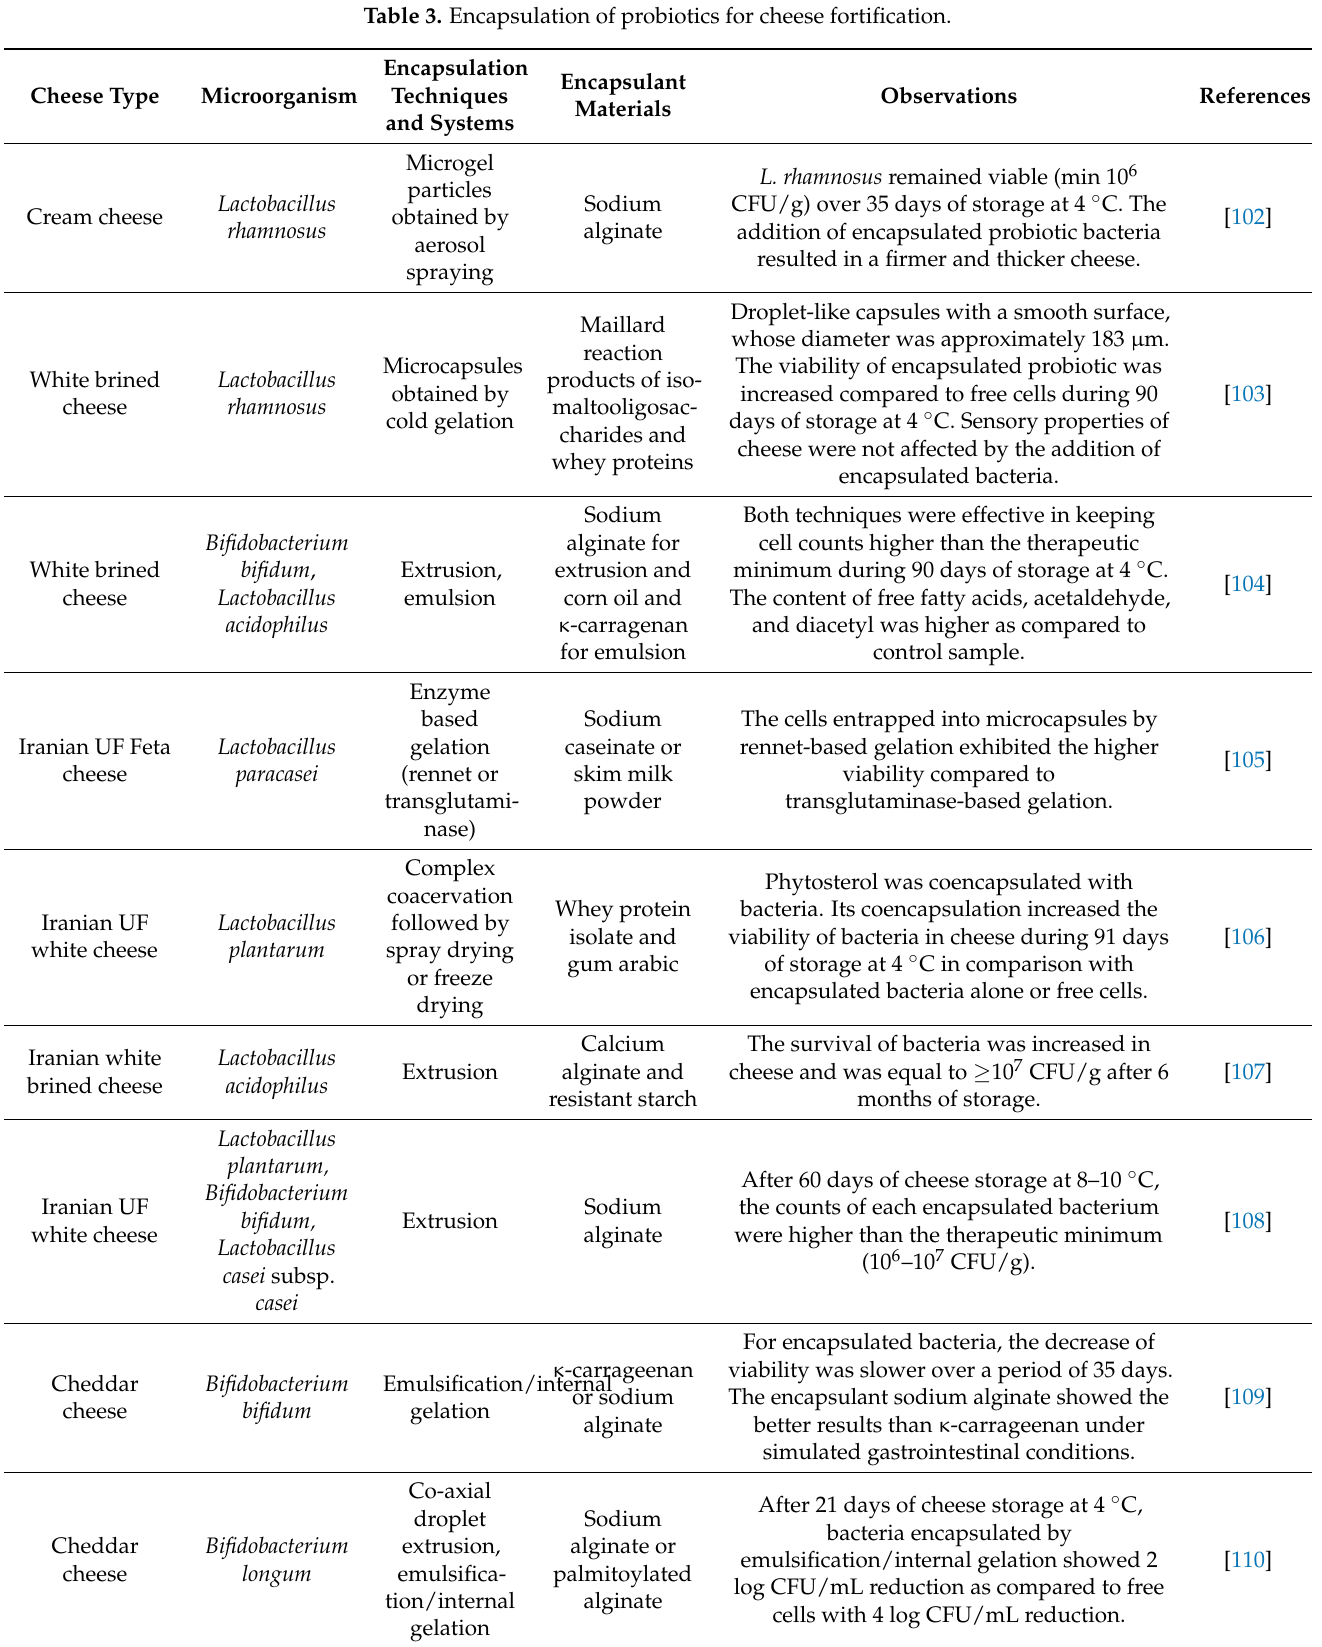
Table 3. Encapsulation of probiotics for cheese